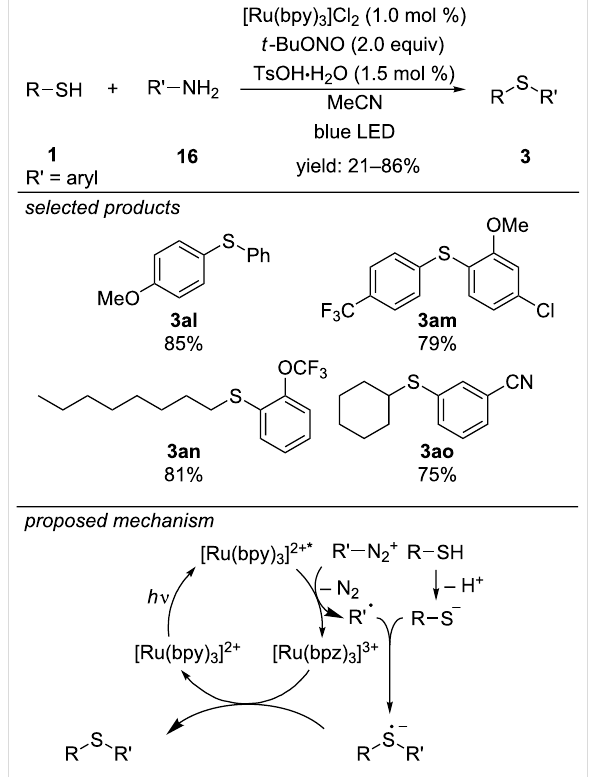
Scheme 16: Photoredox-catalyzed synthesis of diaryl